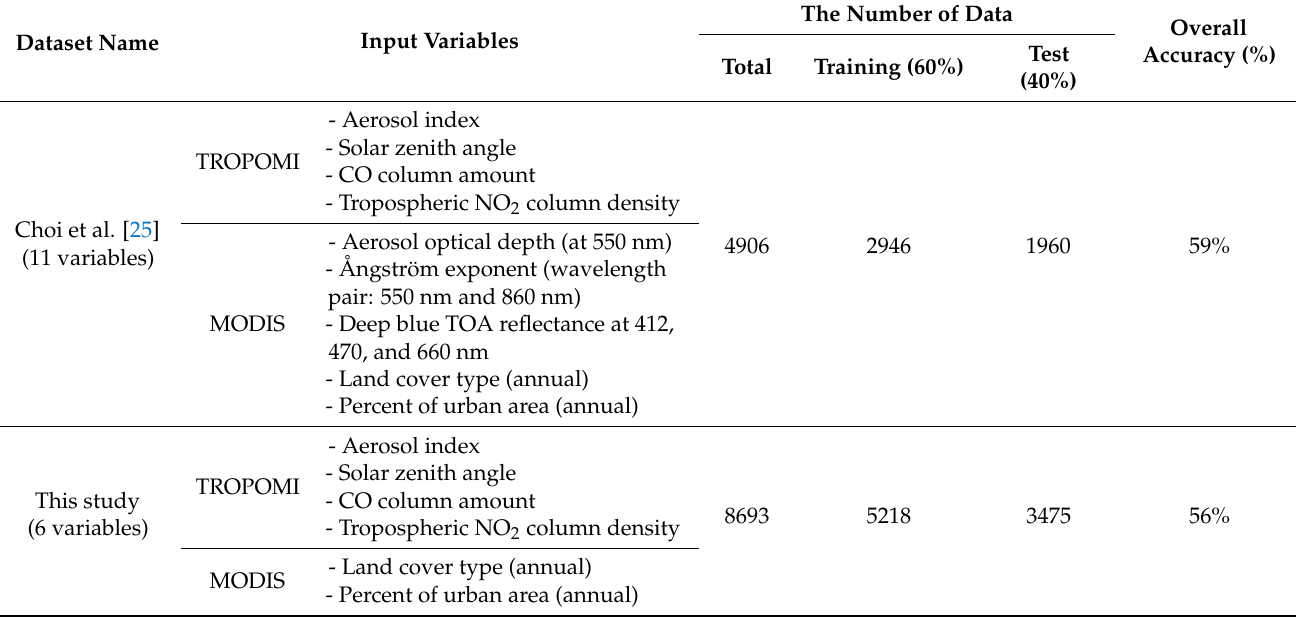
Table 4. Summary of variables, data, and overall accuracy for the initial input variable